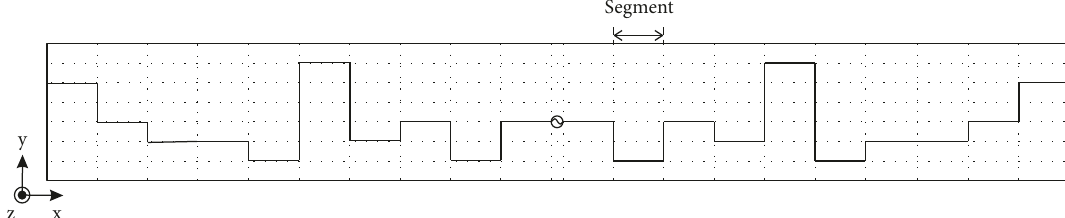
Figure 1: Design concept for a meandered dipole element with a fi xed grid